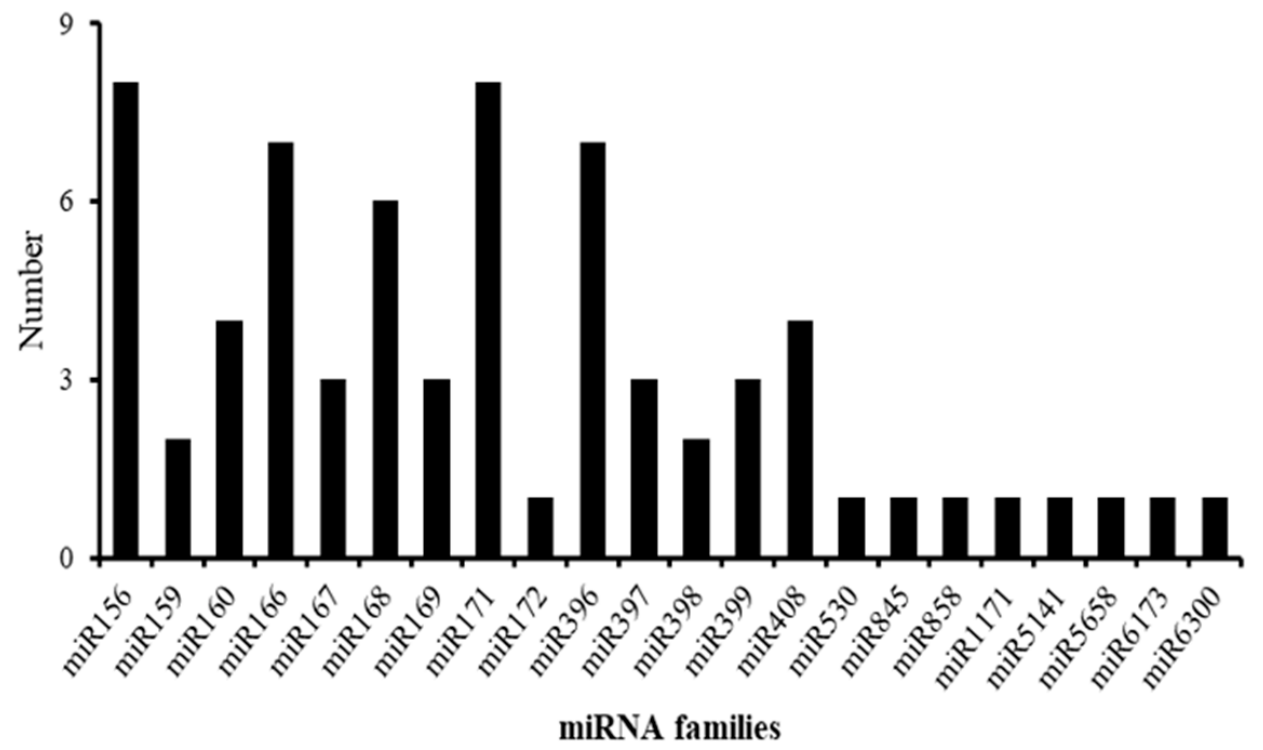
Figure 3. Numbers of miRNA members in each family in rosemary.